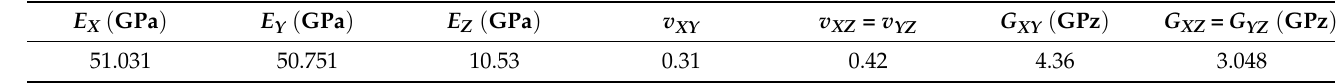
Table 2. Mechanical properties of the SiC f /SiC composites [28].